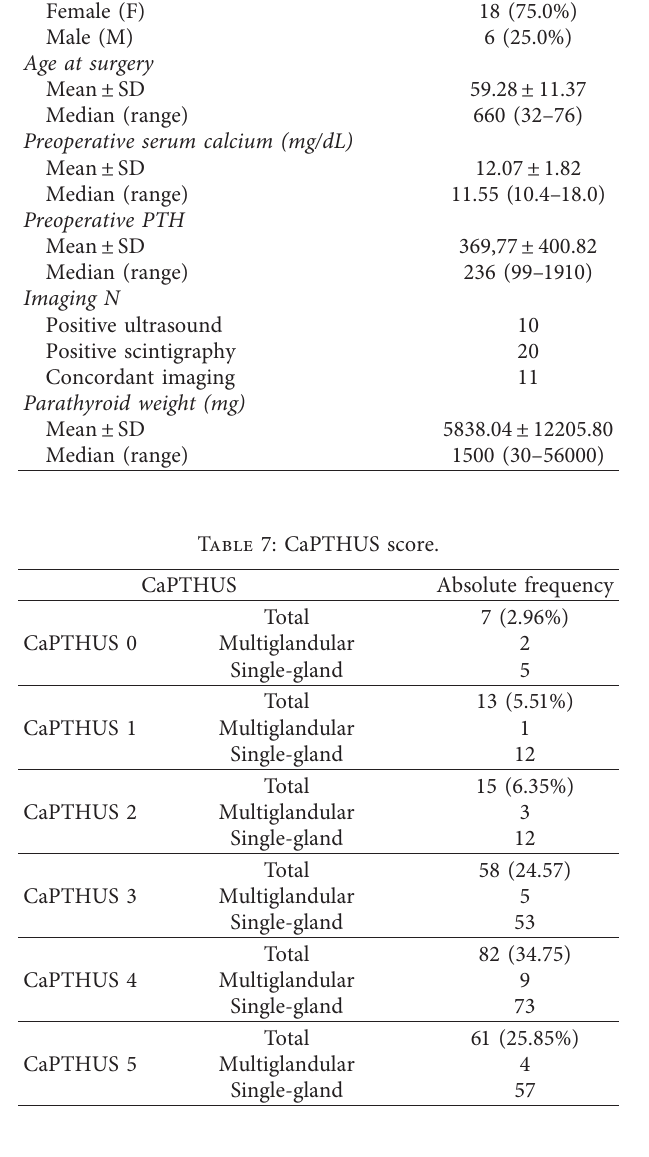
Table 8: CaPTHUS score and ioPTH descent after excision of a single